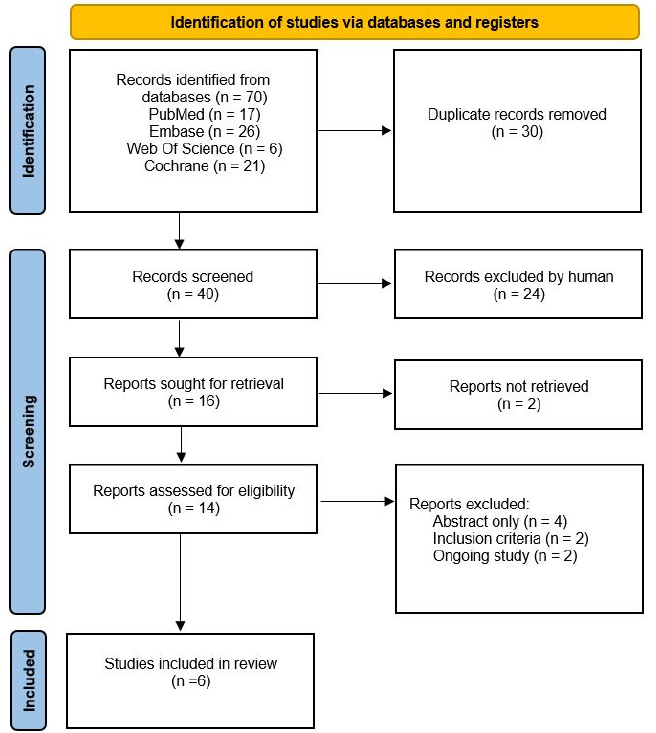
Figure 1. Search strategy and study screening using the PRISMA flow diagram .